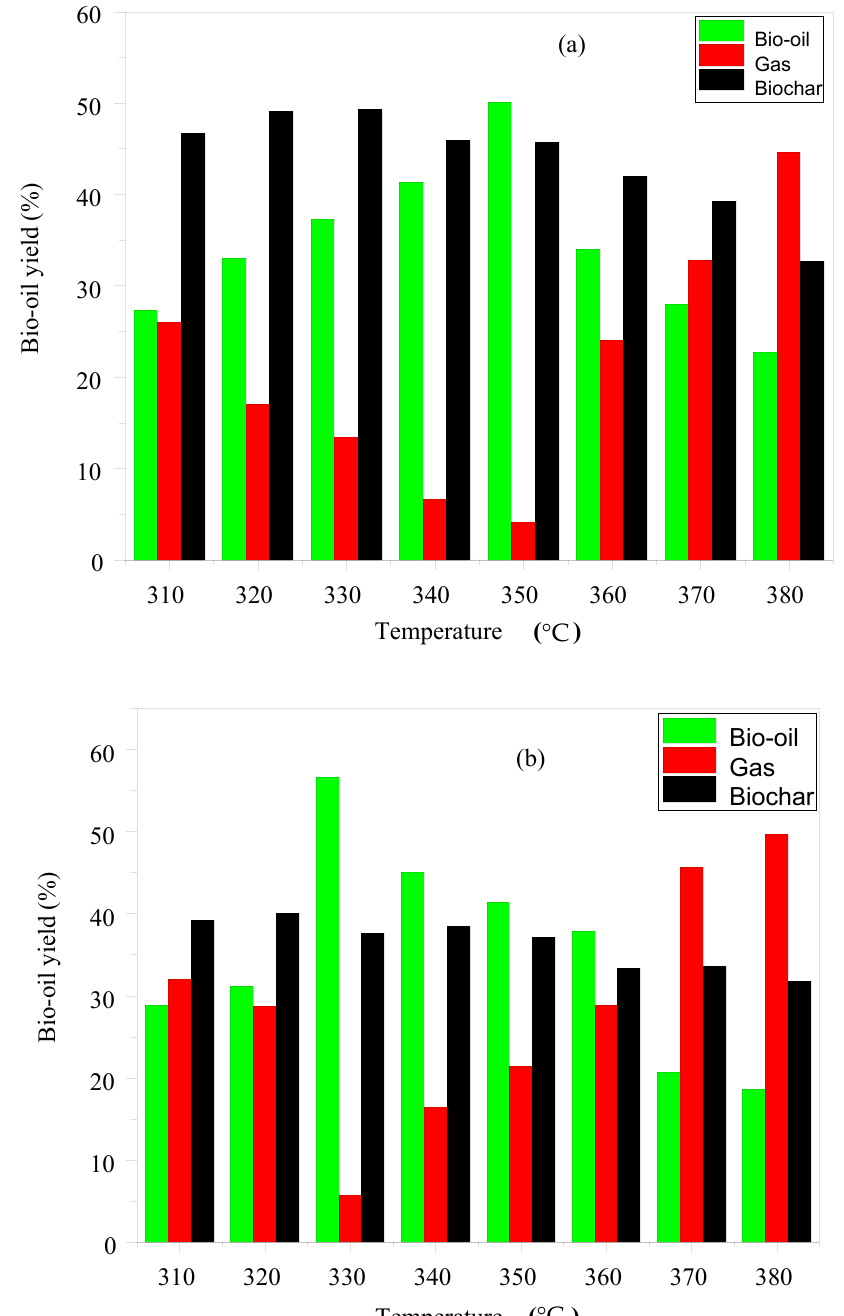
Figure 7. Influence of temperature on pyrolysates ( a ) raw sample; ( b ) impregnated sample. To know the oil composition, GC/MS of the oil from the non-catalyzed reaction was performed and the chromatogram obtained is presented in Figure 8a and the compounds identified are given in Table 1. The oil obtained from raw PP contains compounds in the range of C 5 –C 13 . Furfural with 27.55% area and 5-methyl-2-Furancarboxaldehyde with 12.05% area were the major compounds detected in the oil. Moreover, different types of phenols were also found in abundance. The analysis shows that the bio-oil obtained is a blend of nitrogenated and oxygenated organic compounds. These findings are in consonance with the reported literature [11]. Saadi et al. [31] performed GC/MS of bio-oil recovered from the pyrolysis of waste PP and observed that oxygenated organic compound formation is favored by traditional pyrolysis. The oil produced by flash pyrolysis